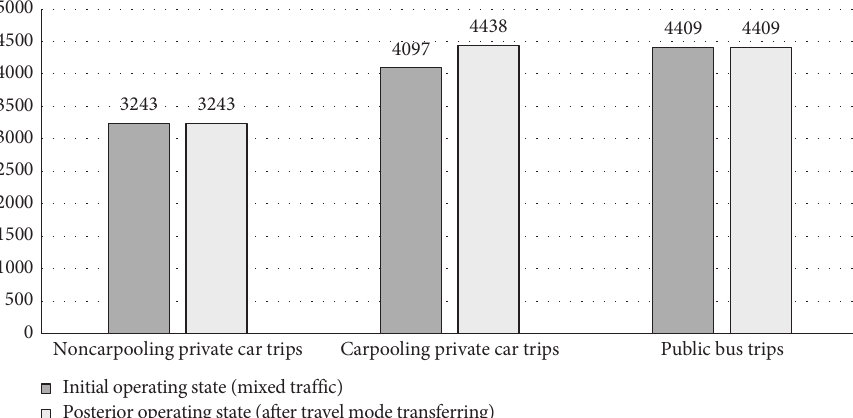
Figure 10: Comparison of travel mileage before and after implementing HOV lanes priority dynamic control for different travel